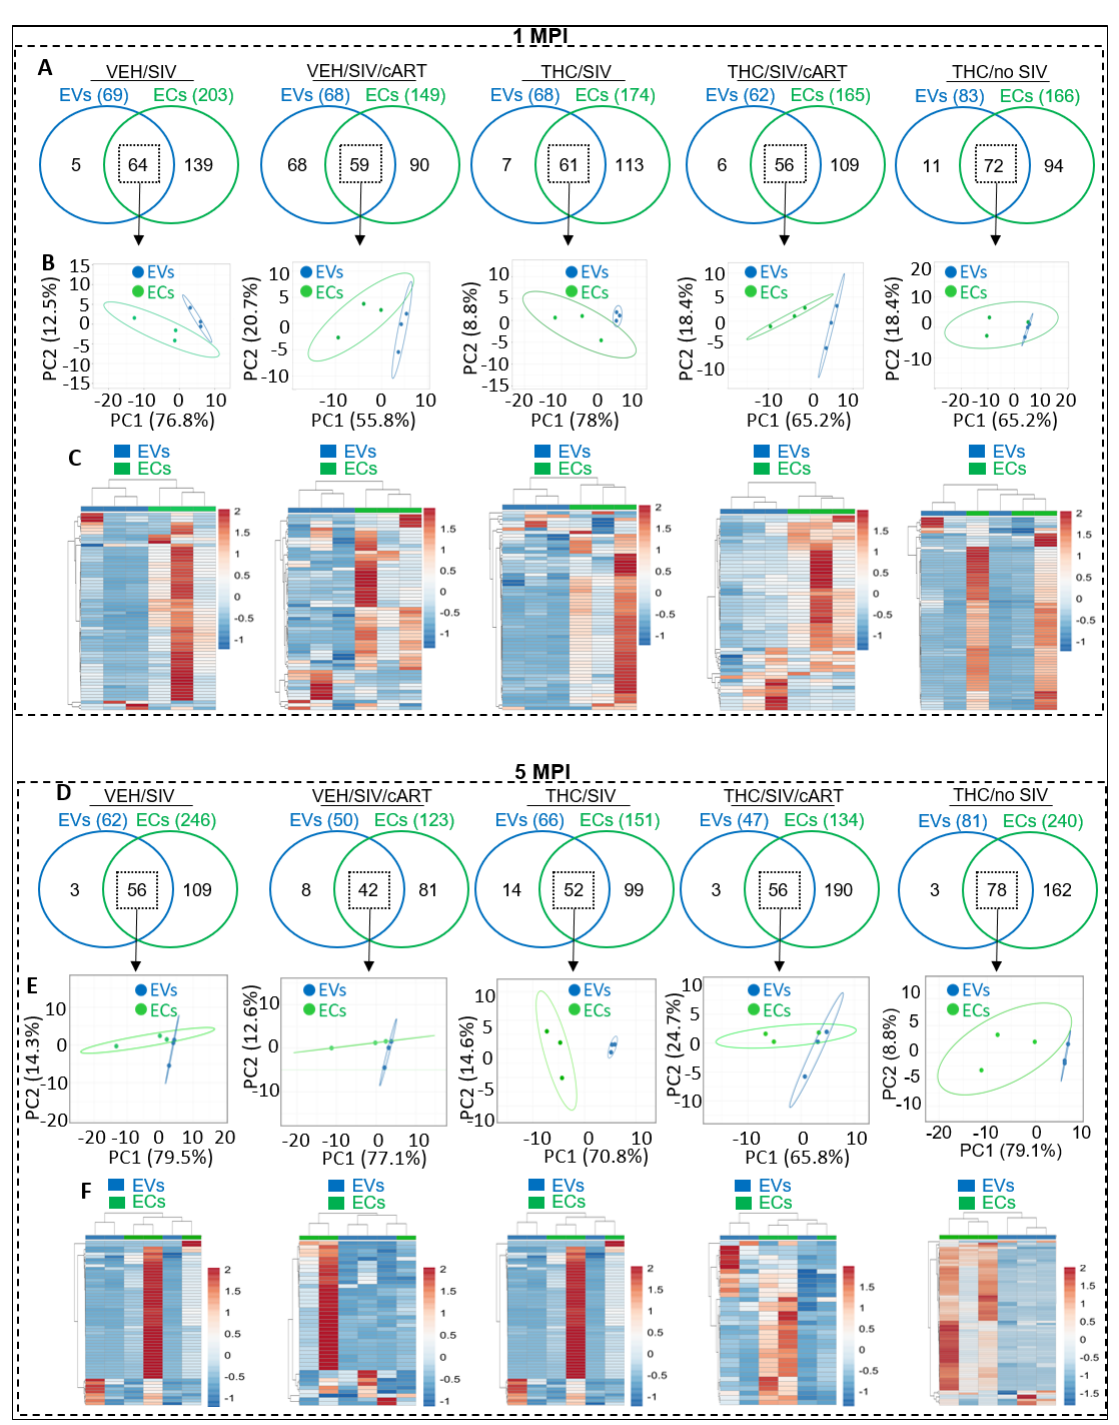
Figure 2. Repertoires of EV − and EC − associated miRNA following SIV infection and treatment with cART and THC. ( A ) Venn diagram comparing total detectable miRNAs for EVs and ECs at 1